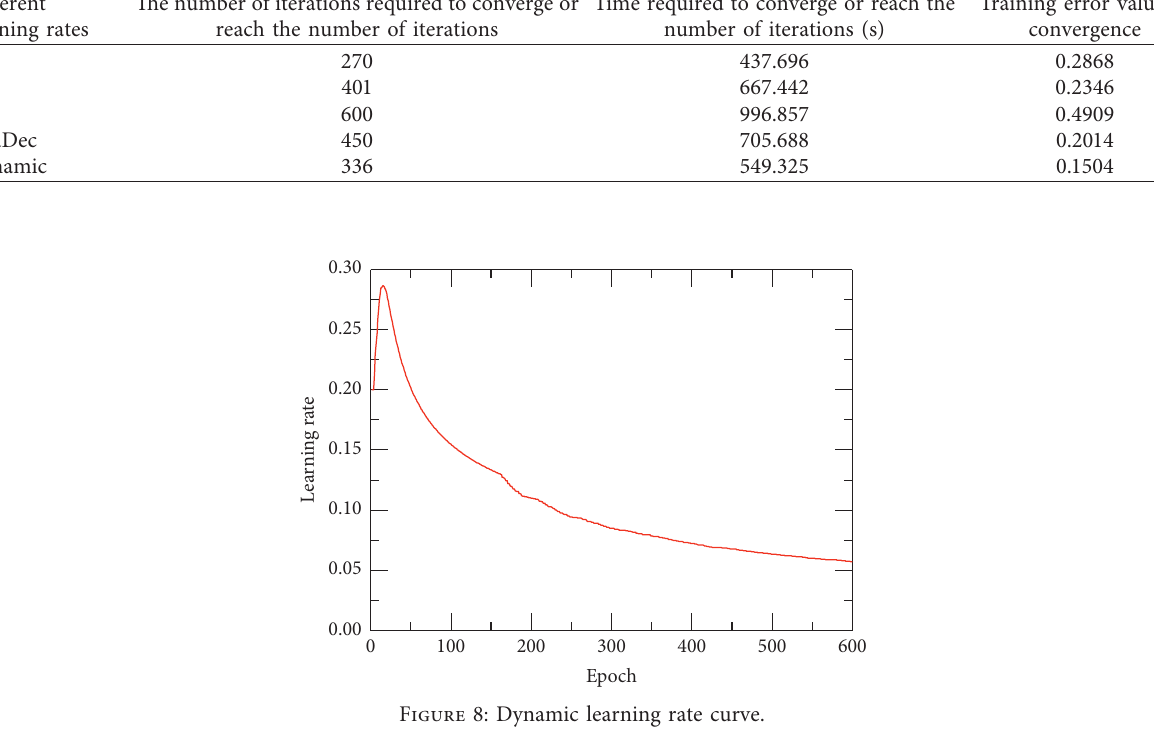
Table 4: Training error of dynamic learning rate with different initial learning